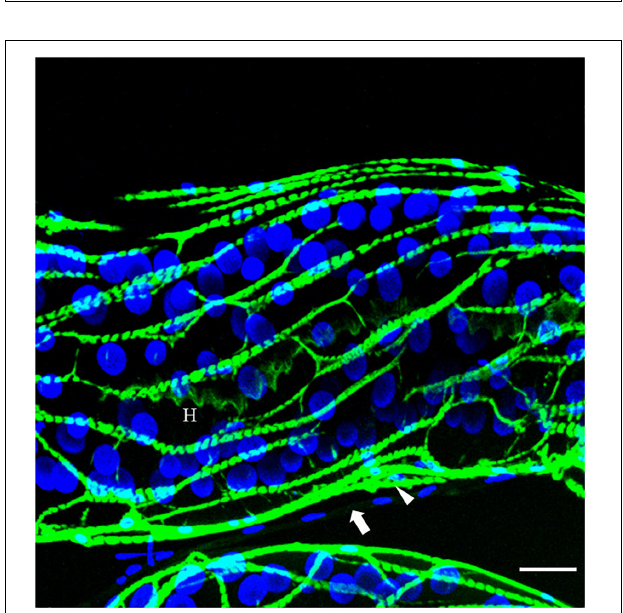
FIGURE 4 | The venom gland of D. rosae observed in confocal microscopy. Merge image of FITC-conjugated phalloidin staining for actin detection (green) and DAPI staining for detection of nucleic acids (blue). H, internal helix containing actin; arrow, surrounding mesenchymal tissue; arrowhead, muscular fiber. Note the round shape of the nuclei of glandular cells. Scale bars = 30 µ